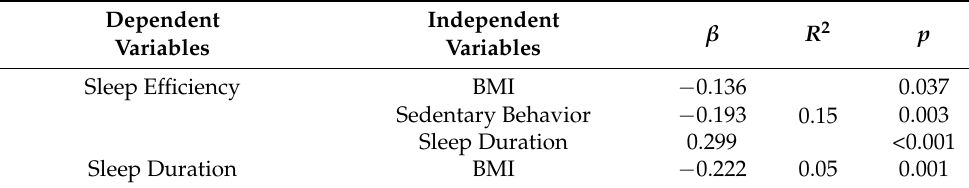
Table 3. Regression analyses among study